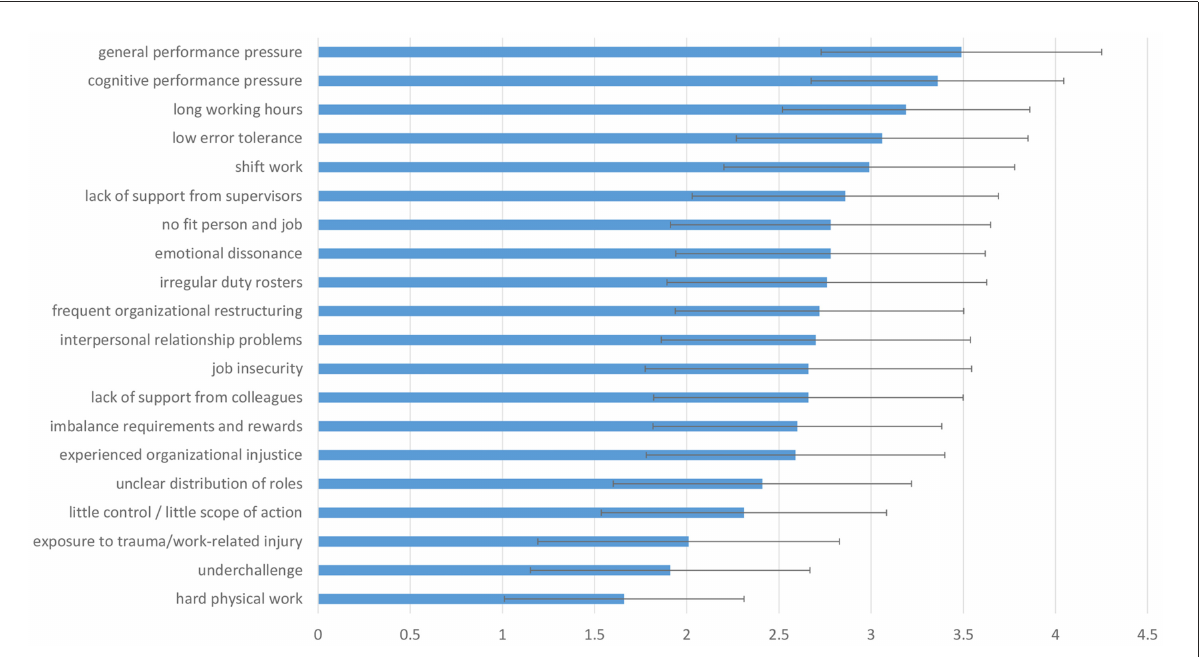
exams in the last month [81.9%; t (303.6) = 2.1, p = 0.04].